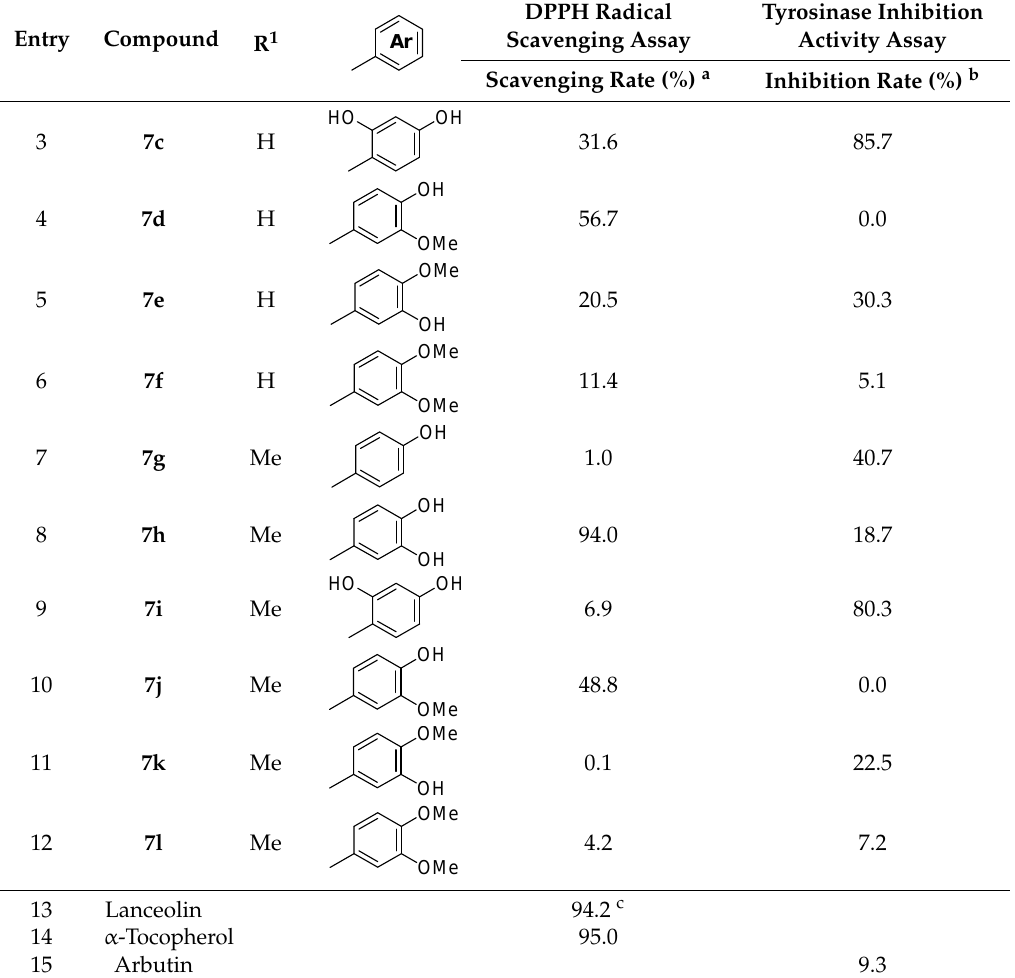
Table 1. The DPPH radical scavenging assay and tyrosinase inhibition activity assay of chalcones 7a – l .